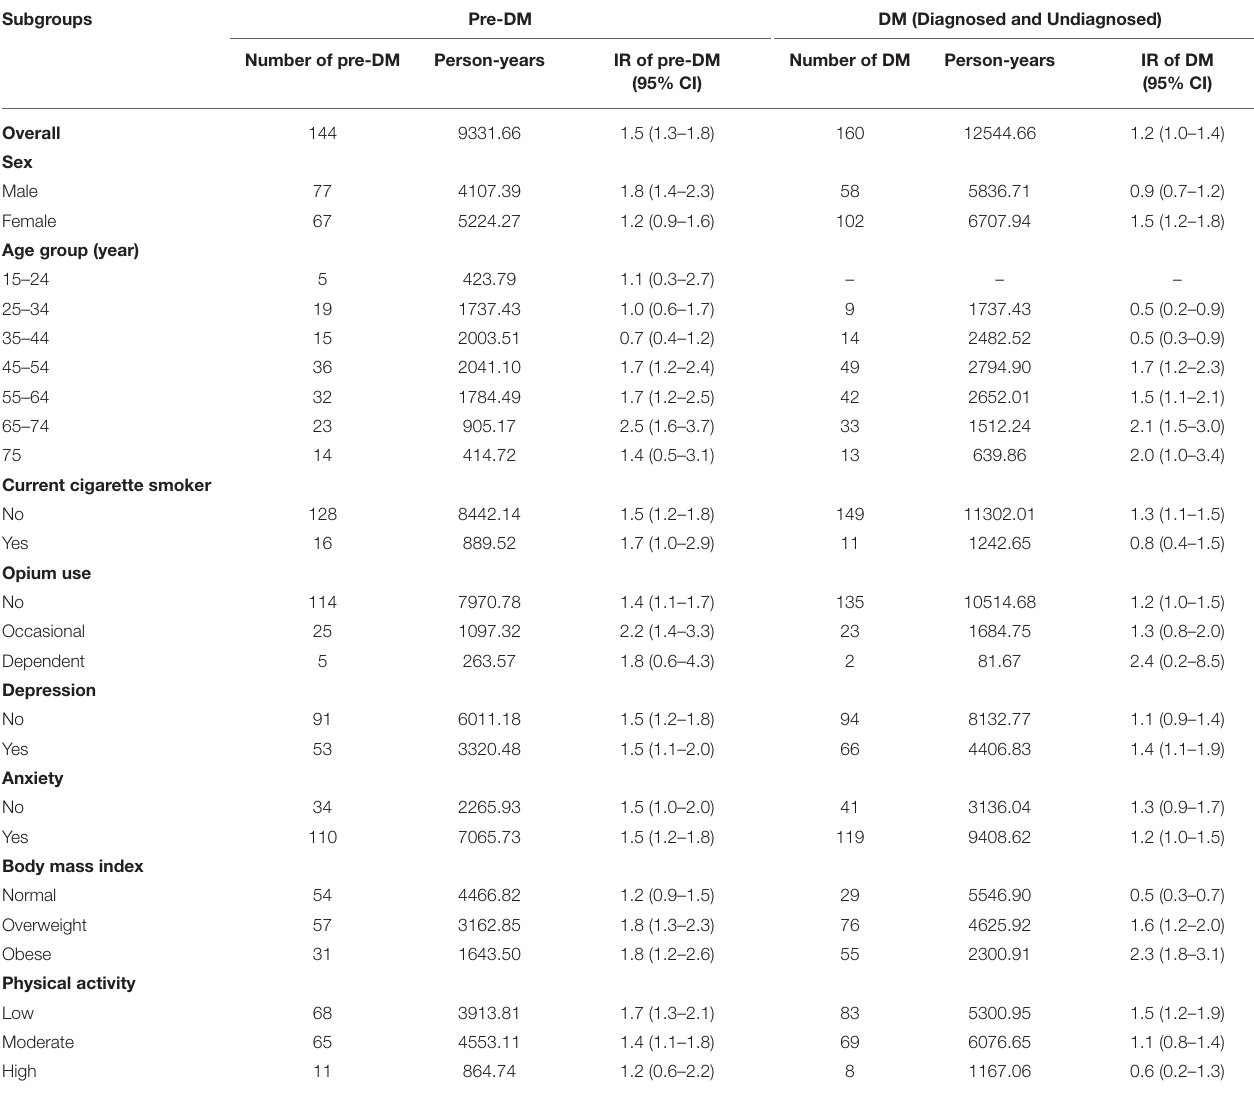
TABLE 4 | Age-Sex-specific incidence rate (IR) (person per 100 person-years) for different associated factors of pre-diabetes and undiagnosed and diagnosed diabetes, community-based cohort study (KERCADRS) 1st and 2nd Phases ( n = 2,820 match cases), Kerman, Iran, phase 1, 2009–2011 and phase 2,